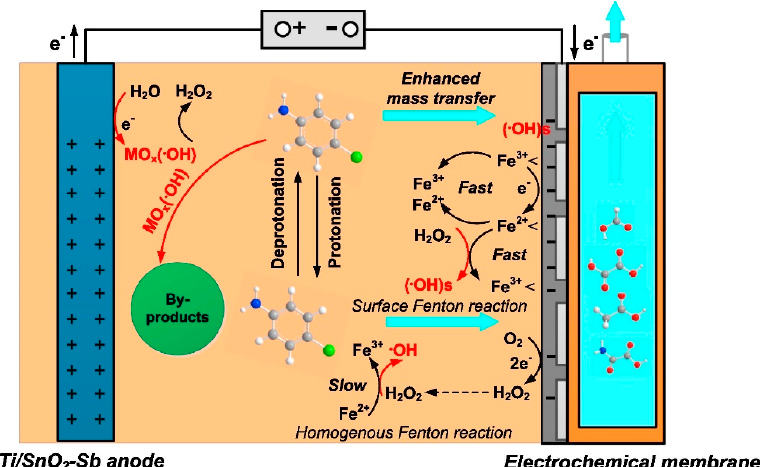
Figure 4. Schematic diagram of cathodic electrochemical filter membrane [107].